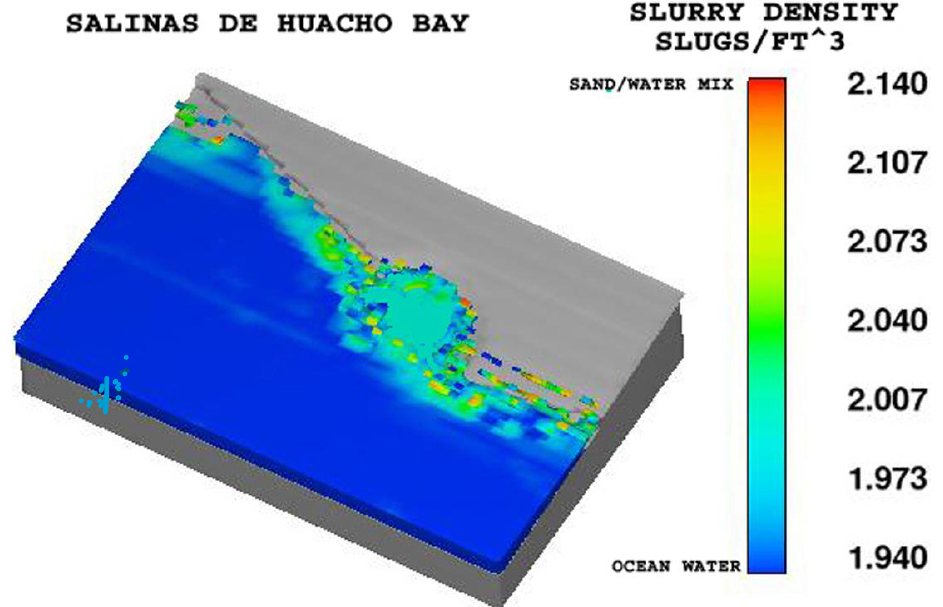
Figure 30. FLOW-3D CFD deposition results of slurry contents in Pacific Ocean coastal area between the Santa and Viru valleys. Result from [2], p. 248. (1 slug/ft 3 = 515.38 kg/m 3 ).